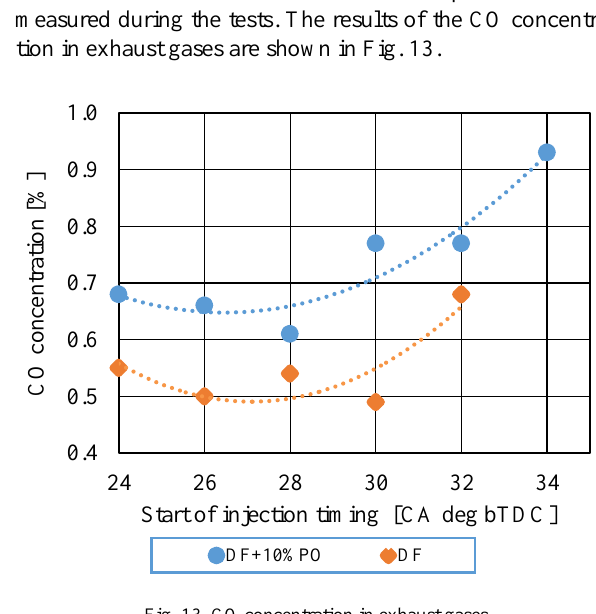
Fig. 13. CO concentration in exhaust gases